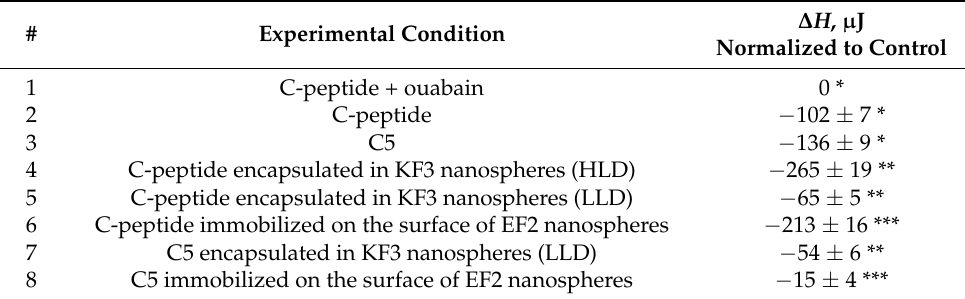
Table 6. Results of isothermal titration microcalorimetry experiments.